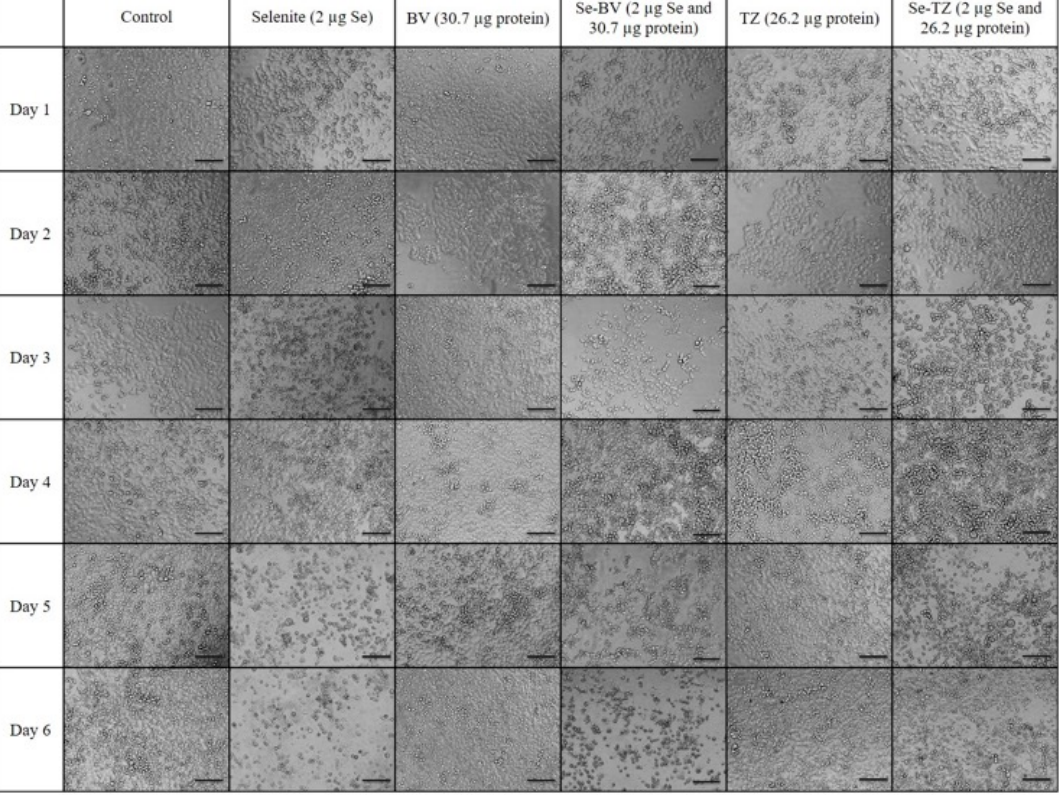
Figure 8. Photomicrographs of the morphological changes observed in control, Selenite, Bevacizumab (BV), Selenobevacizumab (Se-BV), Trastuzumab (TZ) and Selenotrastuzumab-Treated MDA-MB-468 Cells. Treatment of the MDA-MB-468 Cells with Selenite, Se-BV and Se-TZ revealed morphological changes indicative of membrane disruption and decreased cell viability in comparison to the native antibodies BV and TZ. Representative fields of view of MDA-MB-468 cells. Cells were photographed under phase contrast conditions at 20× magnification. Scale bar = 100 µm.